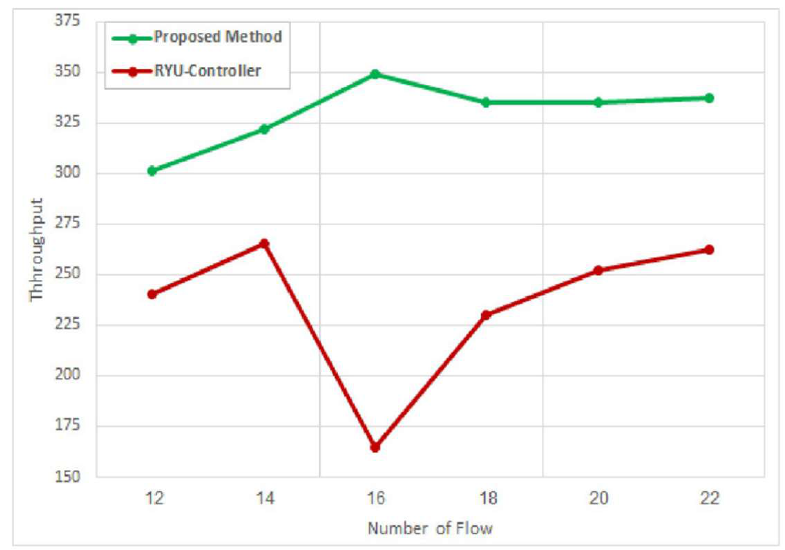
Figure 10. Comparison Between the Proposed Method and the Ryu Controller With Respect to Throughput for Elephant Flows.